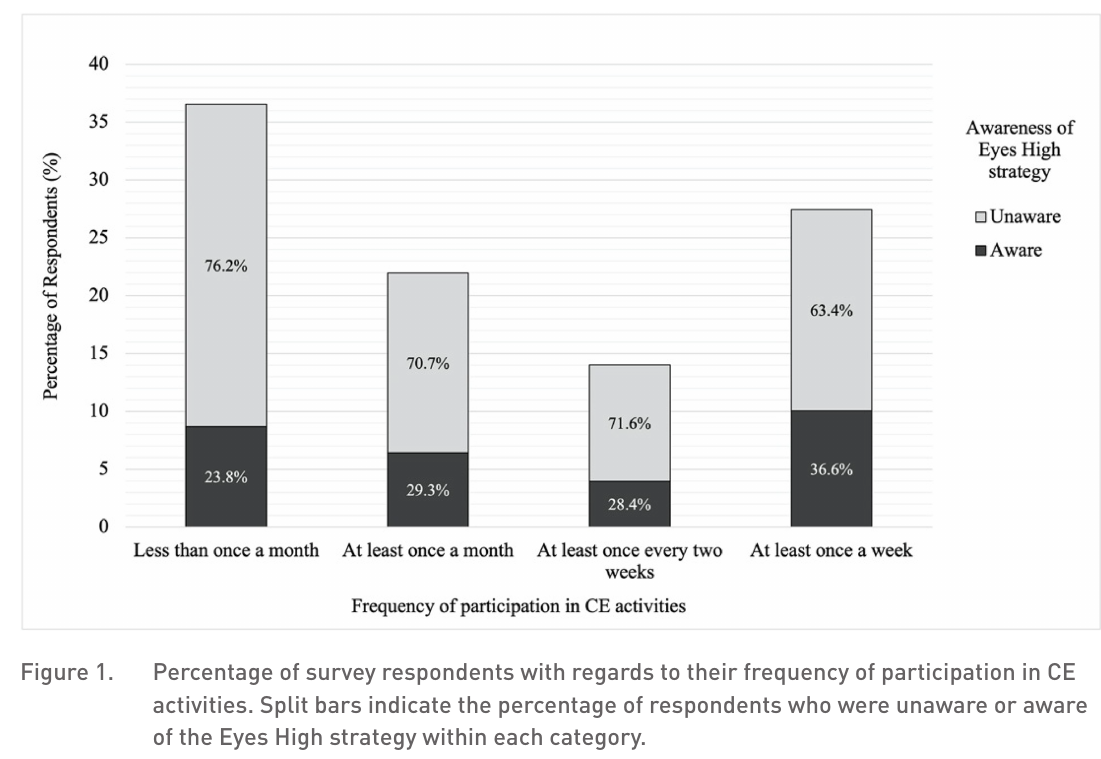
Figure 1. Percentage of survey respondents with regards to their frequency of participation in CE activities. Split bars indicate the percentage of respondents who were unaware or aware of the Eyes High strategy within each